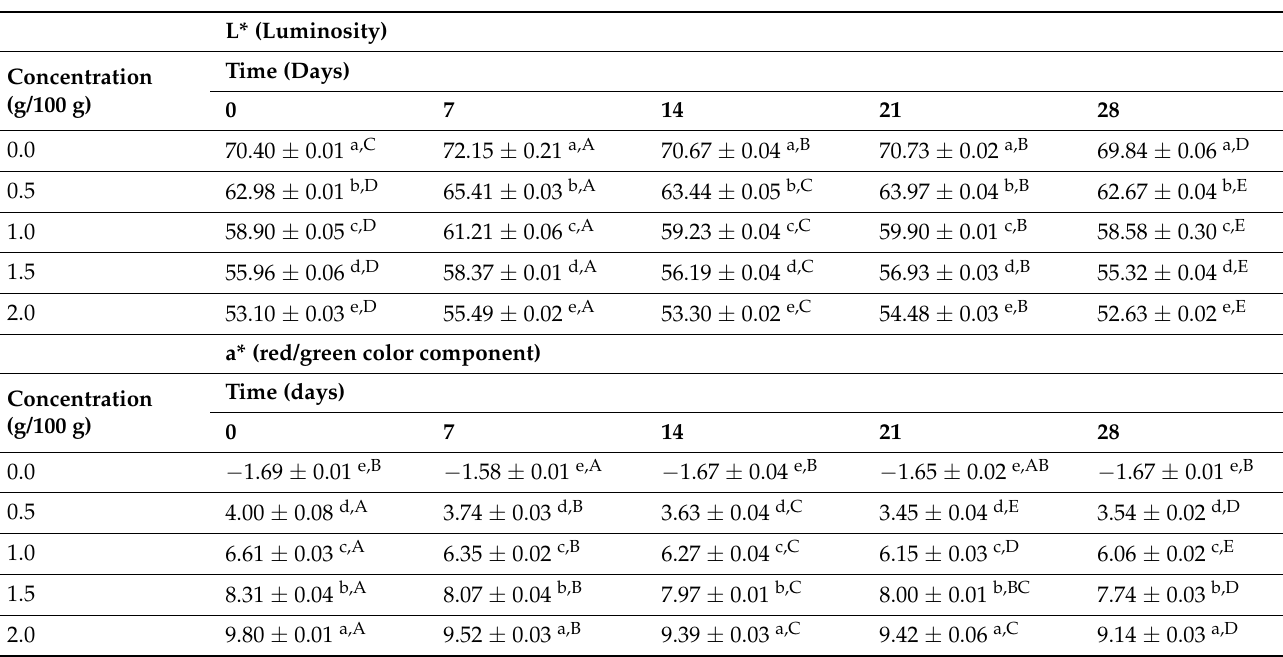
Table 3. Color parameters L*, a*, b*, and C* of sweetened plain whole-fat yogurts with addition of jabuticaba skin powdered extract at different concentration levels during refrigerated